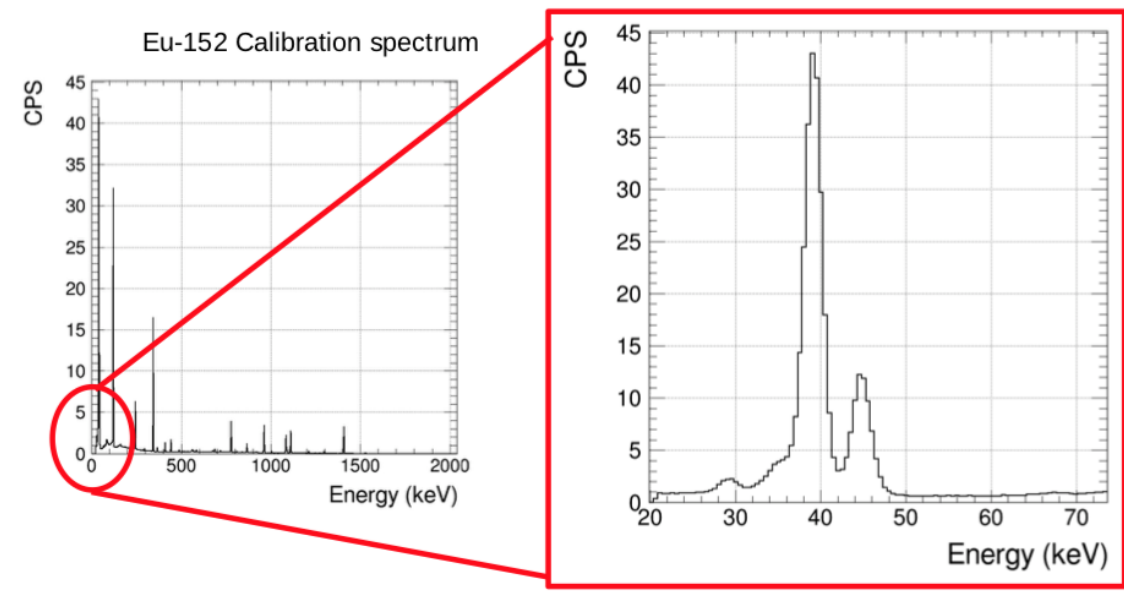
Figure 9. Example of γ -ray spectrum acquired with the HPGe detector and zoom on the X-ray lines from 152 Eu calibration in the 20–70 keV energy